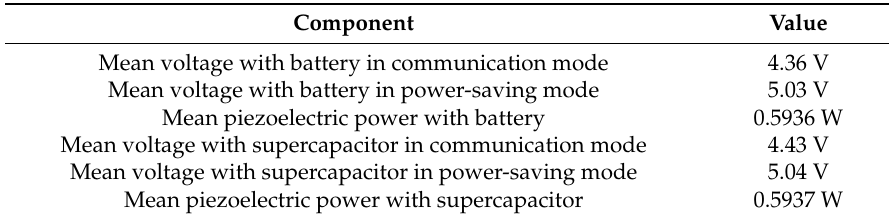
Table 8. Summary of the minimum-power piezoelectric harvester results.